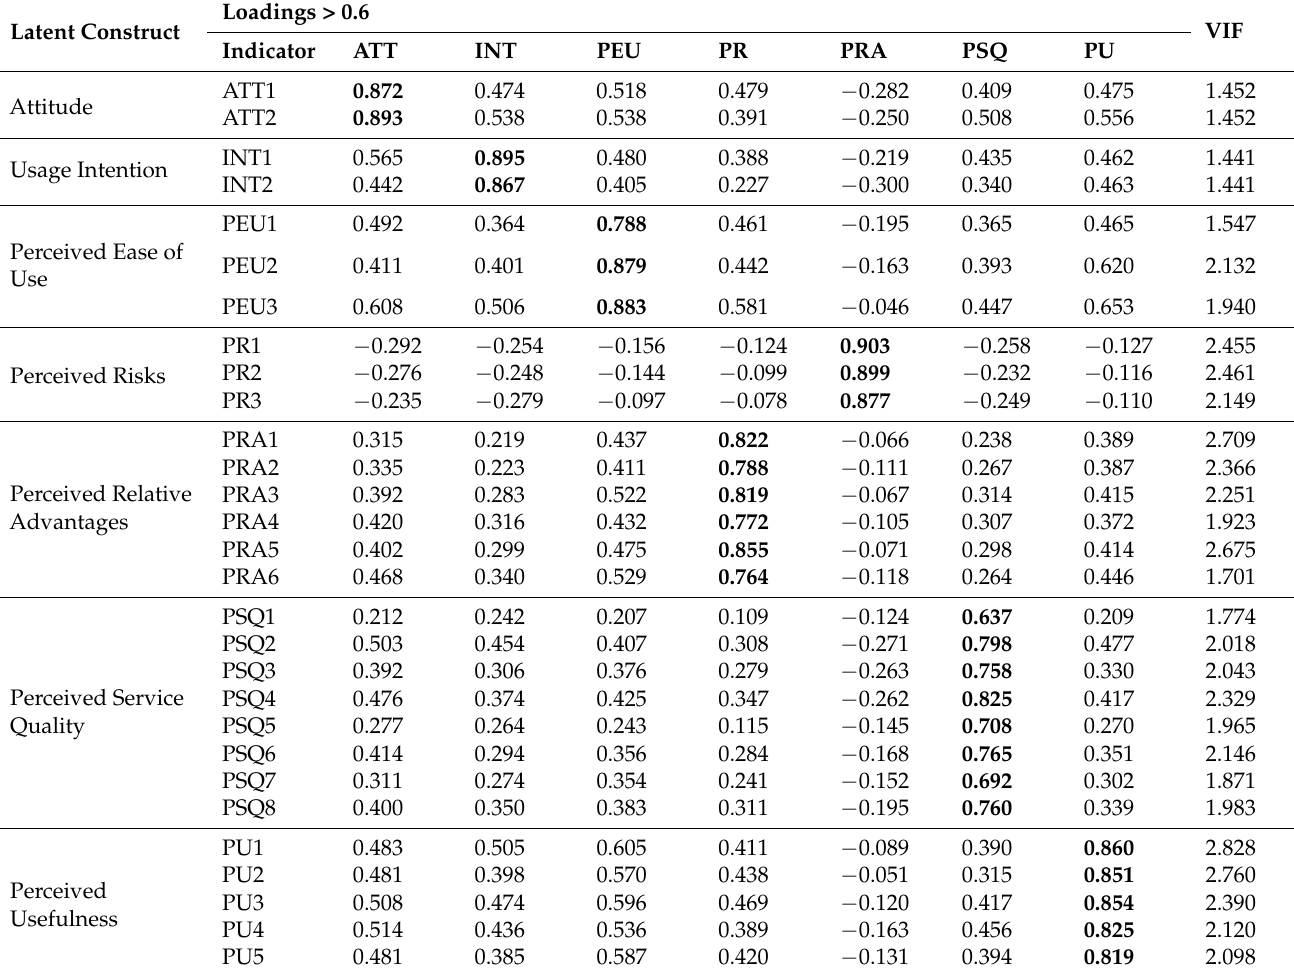
Table 6. Factor loadings (in bold) and